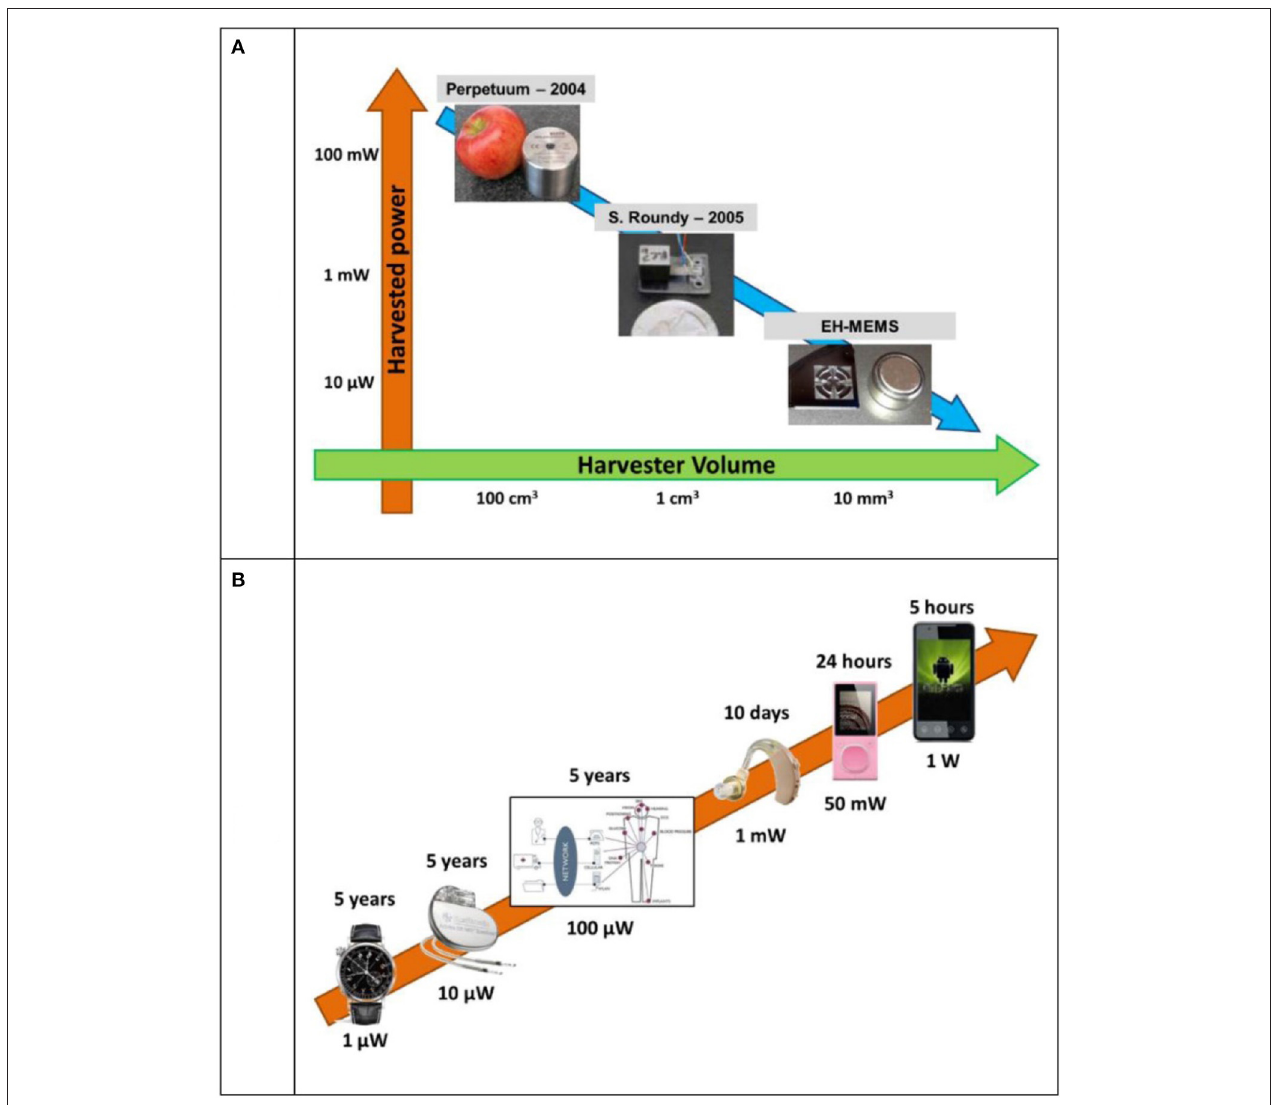
FIGURE 15 | (A) Exsiting microgenerator; (B) Typical low-power devices. Reprint from Iannacci